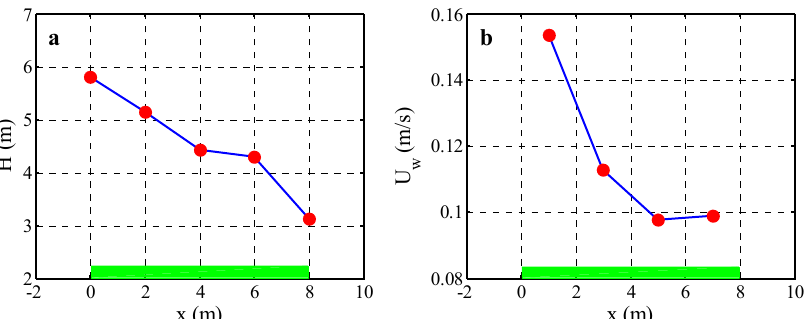
Figure 4. ( a ) Spatial variations of wave height ( H ) through the vegetation canopy (i.e., x = 0–8 m) indicated as green bars; ( b ) Spatial variations of the magnitude of wave orbital velocity ( U W ) through the vegetation canopy. The first 3 U W data points (x = 0–6 m) are obtained from ADV measurement, whereas the last data point at x = 7 m is obtained by using Equation (3) based on an average wave height between x = 6 m and 8 m in panel ( a ). The shown test case is wave0712 with 7 cm wave height and 1.2 s wave period.